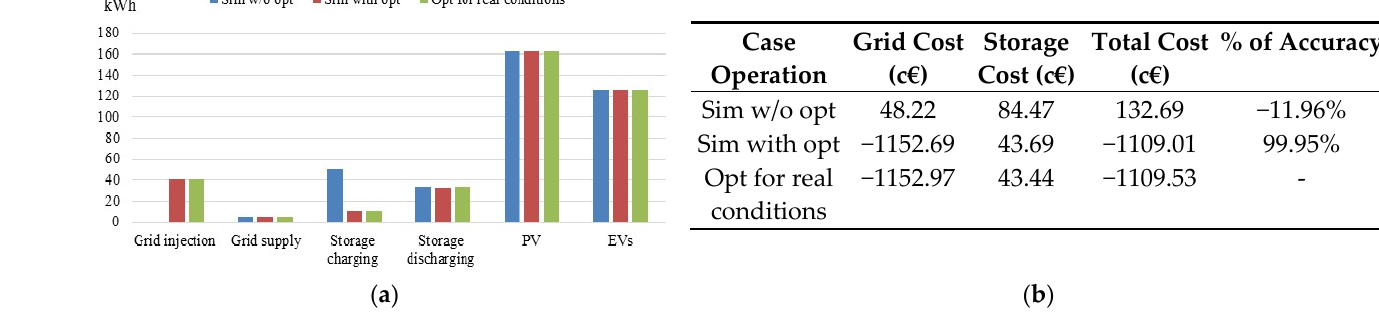
Figure 9. PV MPPT real and predicted powers—case 2. In this case, the weather is clear, so there are no fluctuations; however, the PV power production is not very high. The IIREV demand power is based on the data in Table 2. Figure 10 shows the power flow and storage state of charge for “Sim w/o opt” and simu- lation with optimization “Sim with opt” for case 2. ( a )